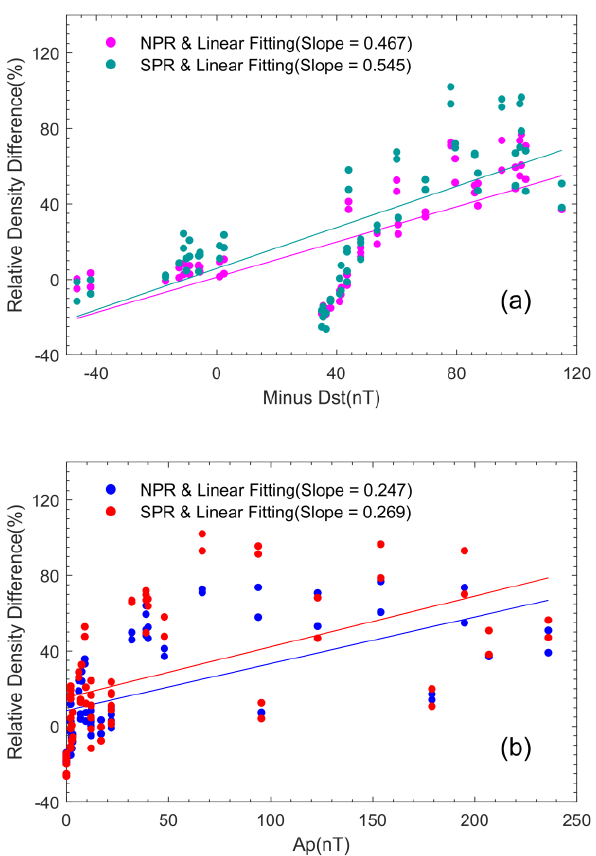
Figure 5. The relationship between the relative density difference of NPR and SPR versus the nega- Dst index ( a ) and Ap index ( b tive Dst index ( a ) and Ap index ( b ).